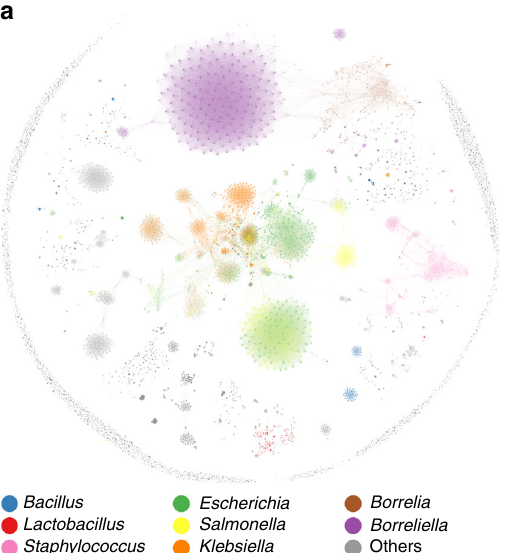
Fig. 3 ANI L50 similarity network of the bacterial plasmidome. Similarity networks of the RefSeq84 prokaryotic plasmidome obtained using the ANI L50 algorithm as described in Methods. Nodes, corresponding to plasmid genomes, are colored according to their cognate host taxonomy ( a ) or MOB class, as de fi ned by MOBscan ( b ). Source data are provided as a Source Data fi